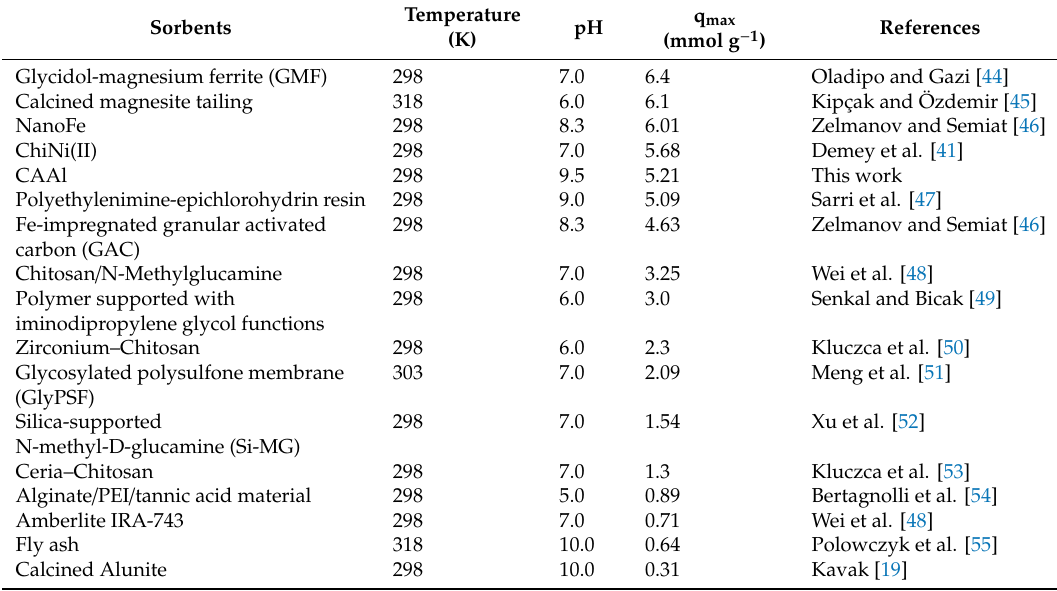
Table 3. Comparison of boron sorption capacities for several sorbents.